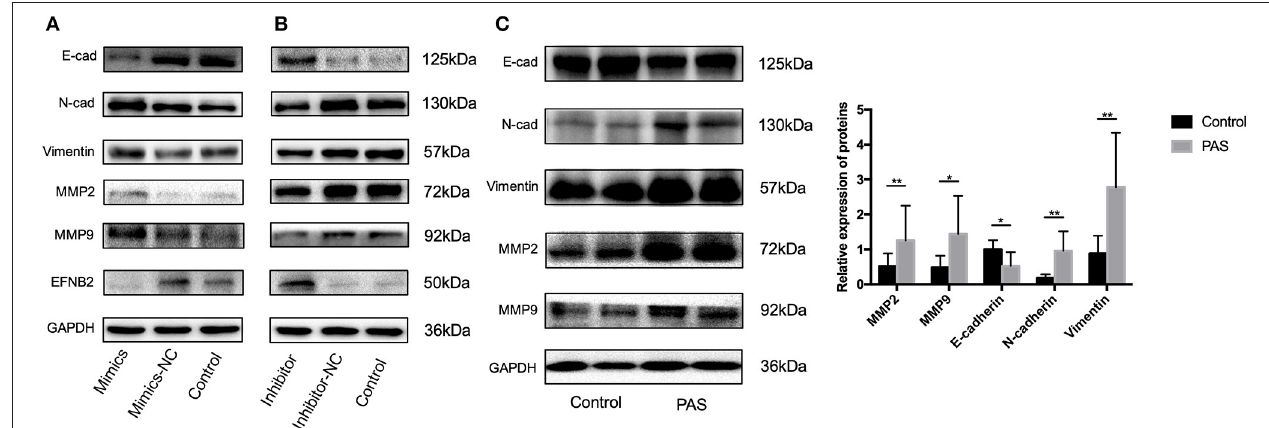
FIGURE 3 | The EMT pathway is activated by miR-193a-3p in placenta accreta spectrum patients. (A) Protein levels of E-cad, N-cad, vimentin, MMP2, MMP9, and EFNB2 examined by western blot in HTR-8/SVneo cells transfected with miR-NC and miR-193a-3p mimics. (B) Protein levels of E-cad, N-cad, vimentin, MMP2, MMP9, and EFNB2 examined by western blot in HTR-8/SVneo cells transfected with miR-193a-3p-inhibitor-NC and miR-193a-3p-inhibitor. (C) Protein levels of E-cad, N-cad, vimentin, MMP2, and MMP9 examined by western blot in placenta accreta spectrum and control placental tissues. All data are presented as the mean ± standard deviation. PAS, placenta accreta spectrum; EFNB2, Ephrin-B2; mimics, miR-193a-3p mimics; inhibitor, miR-193a-3p inhibitor; NC, negative control. * P < 0.05, ** P < 0.01.